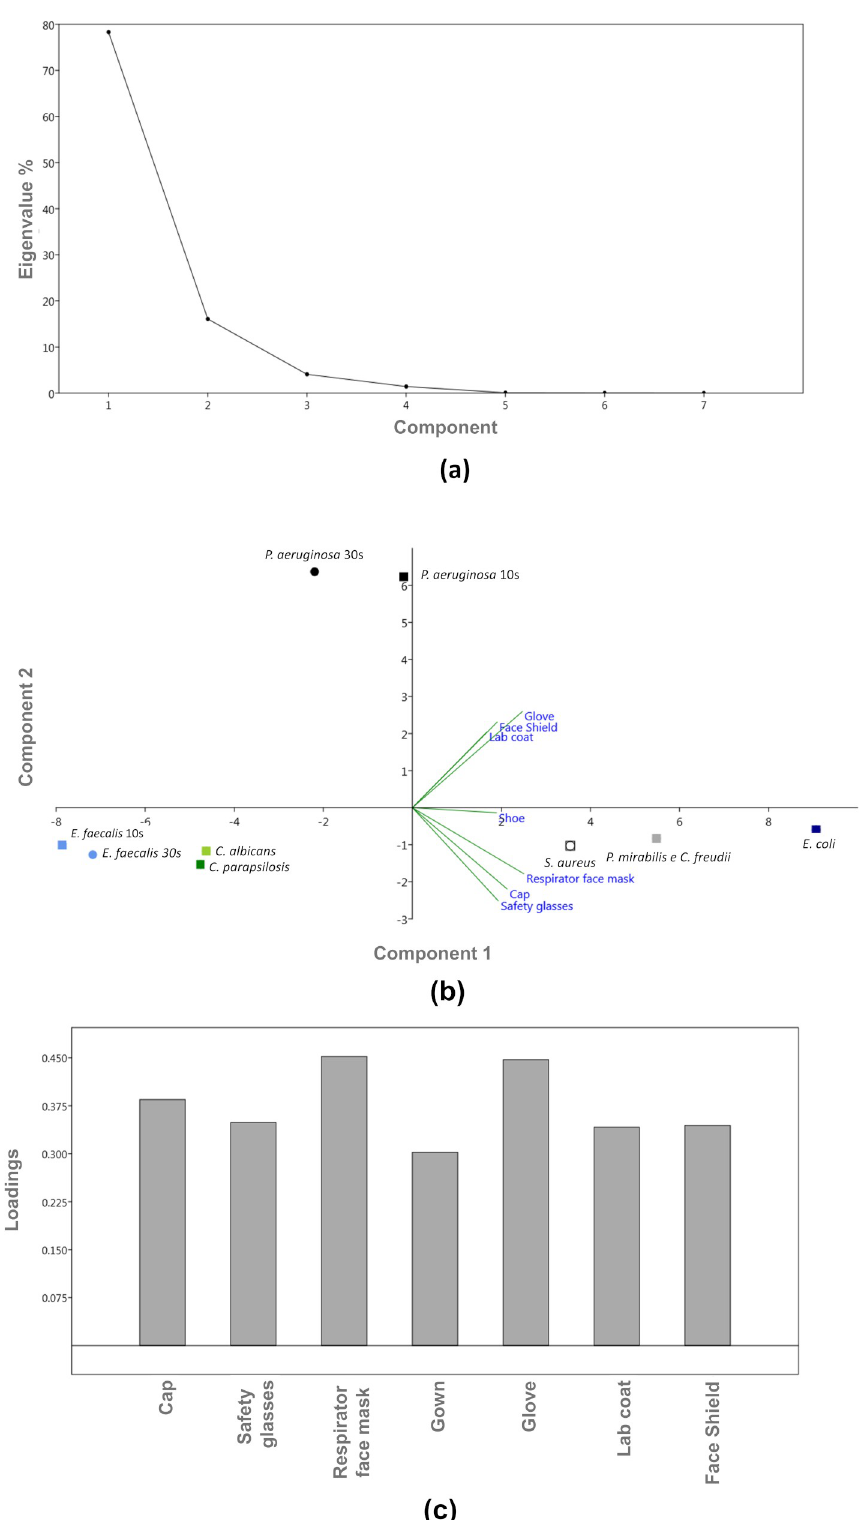
Fig 4. Principal component analysis of the samples of the test microorganisms analyzed at 10 and 30 s: (a) cumulative variance according to the quantity of components (PPE–cap, safety glasses, respirator face mask, lab coat, glove,